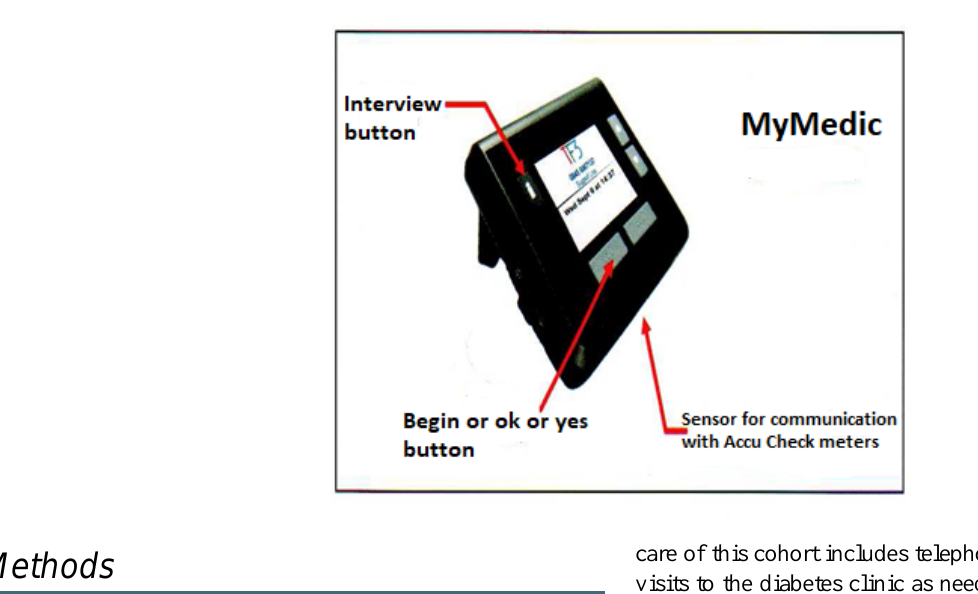
Figure 1. MyMedic